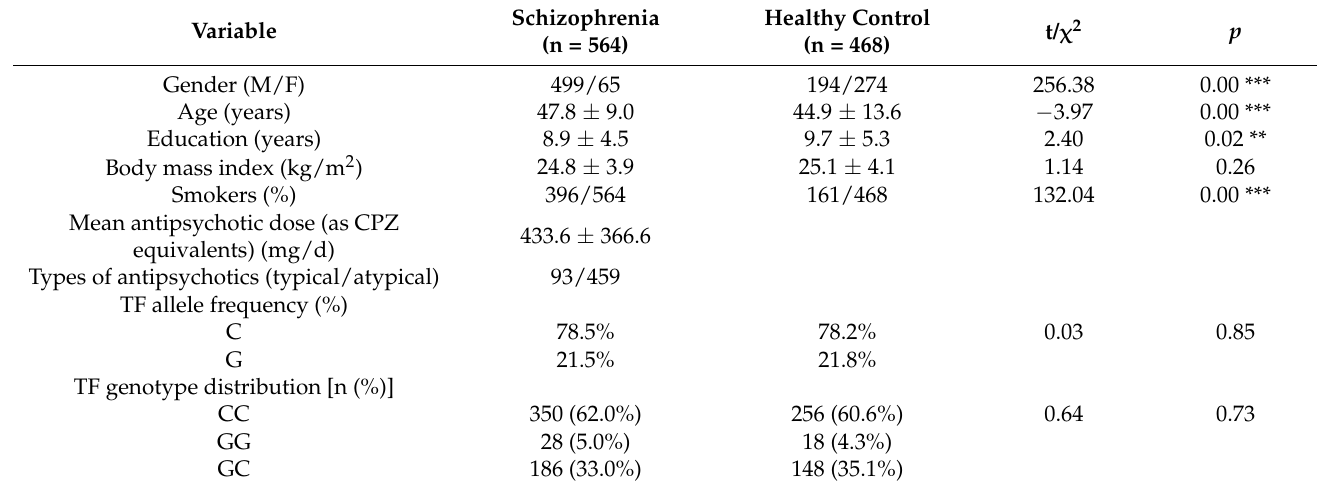
Table 1. Demographics and genotype distributions of the participants.